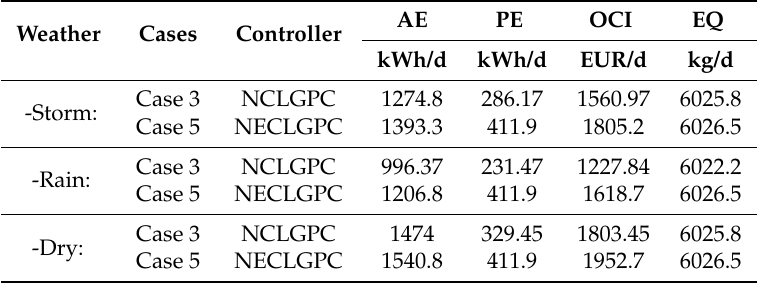
Table 7. Comparison of performance indices for cases 3 and 5